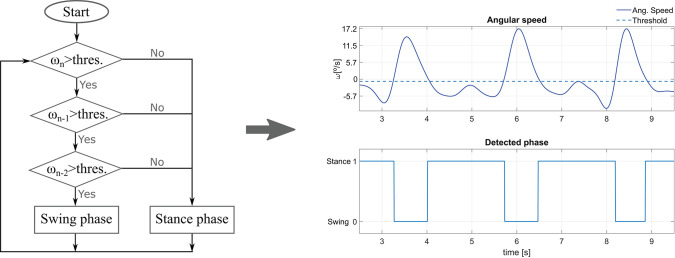
(Left) Flowchart of the gait phase detection method. ω denotes the thigh angular velocity, while n stands for the sample time. (Right) Impaired leg phase detection using the method for an average experiment volunteer.